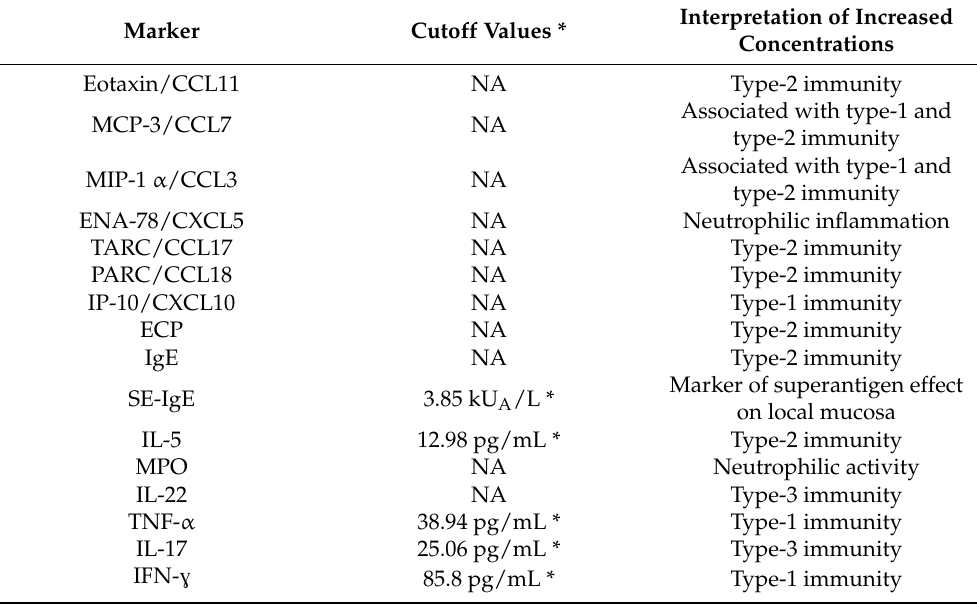
Table 2. Markers used for the component and cluster analysis, the cutoff values for markers analyzed as